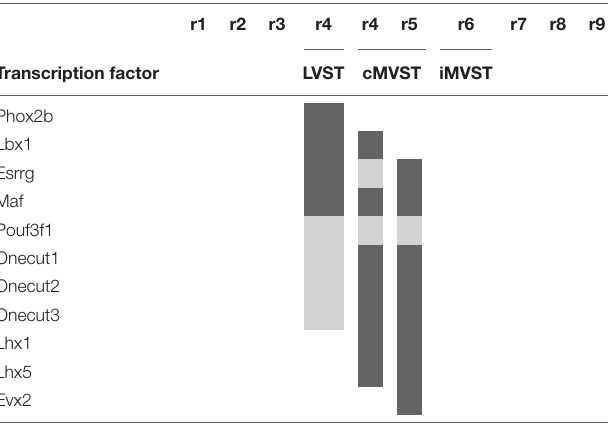
TABLE 1 | Molecular profiling of the vestibulospinal neuron groups related with rhombomeres [based on Lunde et al.